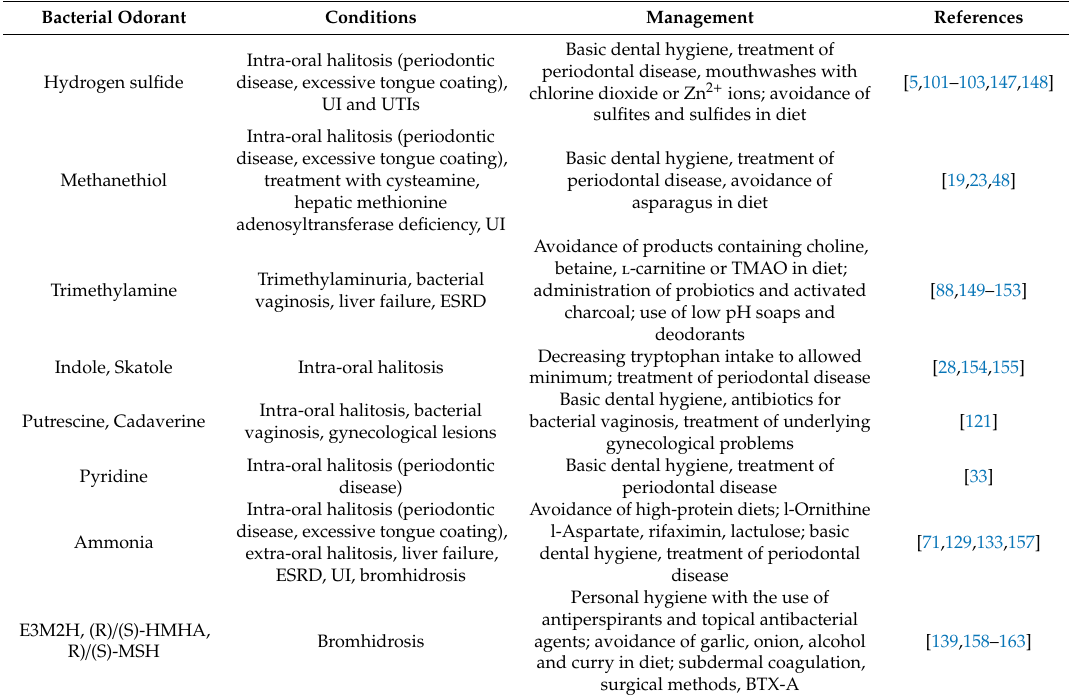
Table 3. Management by the type of bacterial